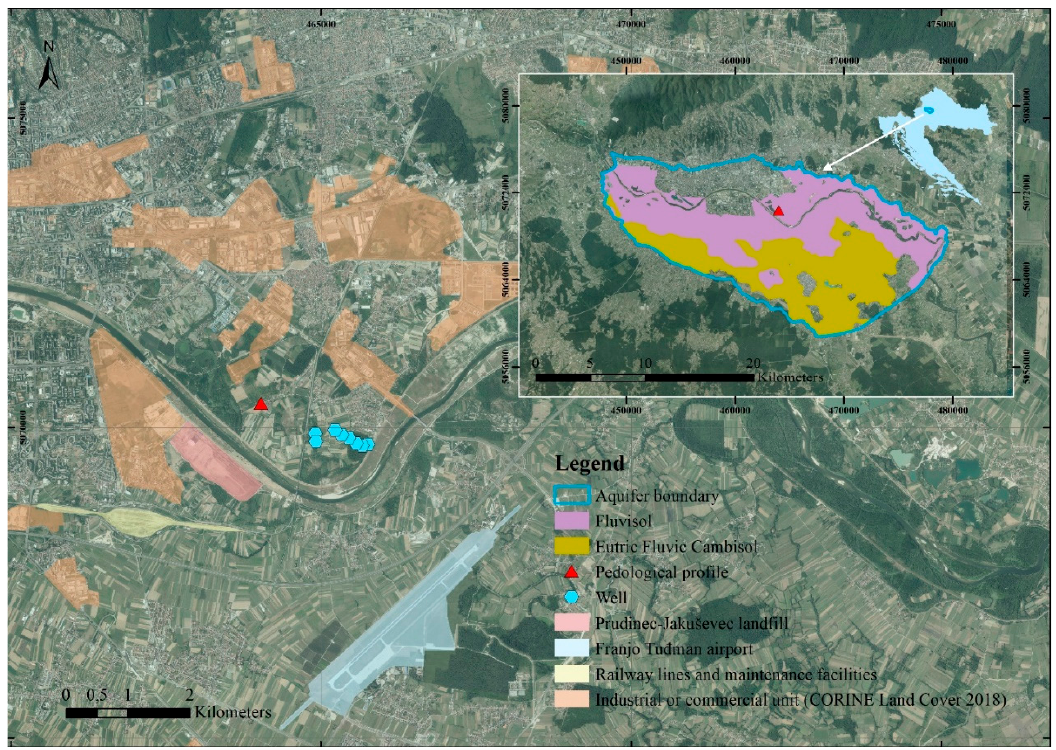
Figure 1. Geographical map of study area with location of pumping wells at the well field Petruševec, investigated soil profile and potentially contamination sources.